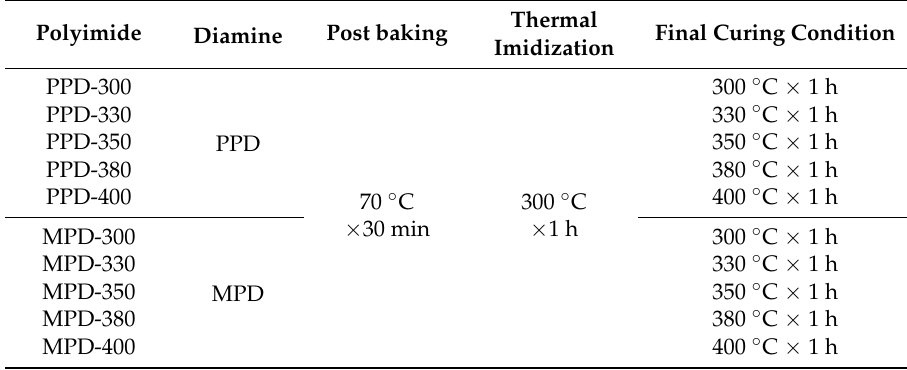
Table 1. Thermal curing conditions of PI